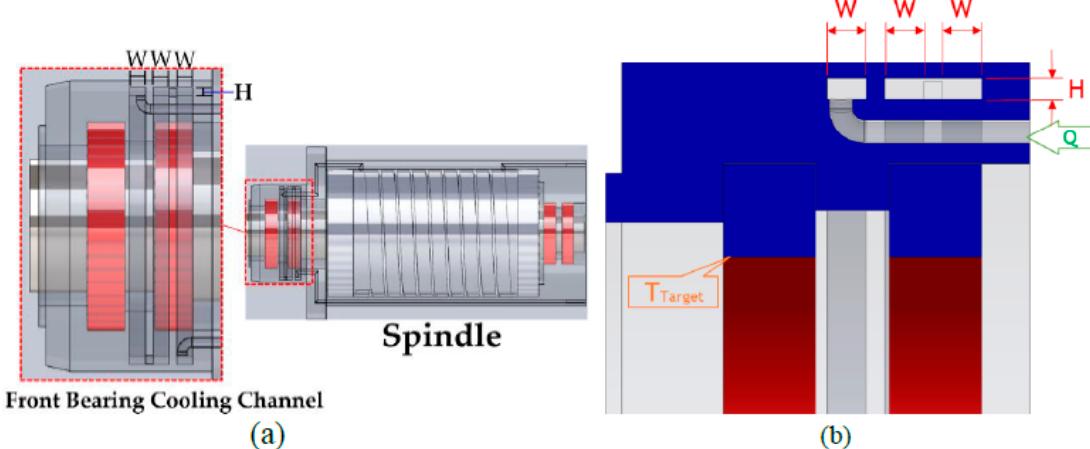
Figure 9. Schematic of critical dimensions of front bearing channel. ( a ) Critical dimension of front bearing cooling channel; ( b ) optimization variable settings.